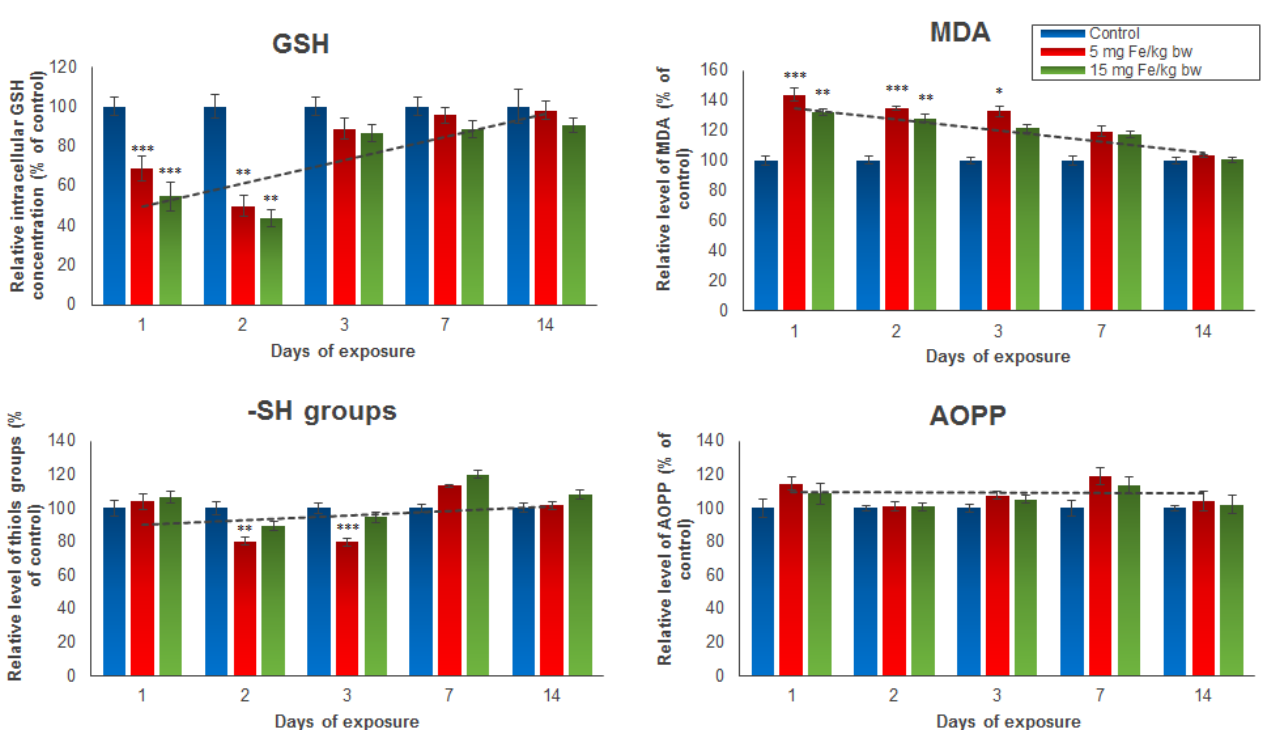
Figure 2. The levels of GSH, MDA, -SH groups, and AOPP from mice kidney tissue extracts, after 1, 2, 3, 7, and 14 days from the administration of 5 and 15 mg of Fe/kg bw of IONPs encapsulated in phospholipid-based micelles. The values are calculated as the mean ± standard deviation (SD) and are expressed as percentages related to the control group; the results were considered statistically significant when * p < 0.05; ** p < 0.01; *** p < 0.001 versus the control group. The dotted line indicates the tendency of parameter variation.